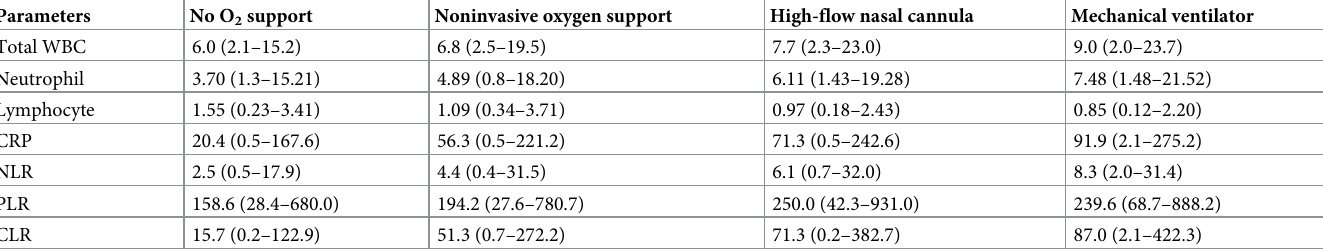
Table 4. The inflammatory marker among COVID patients requiring different types of oxygen support.